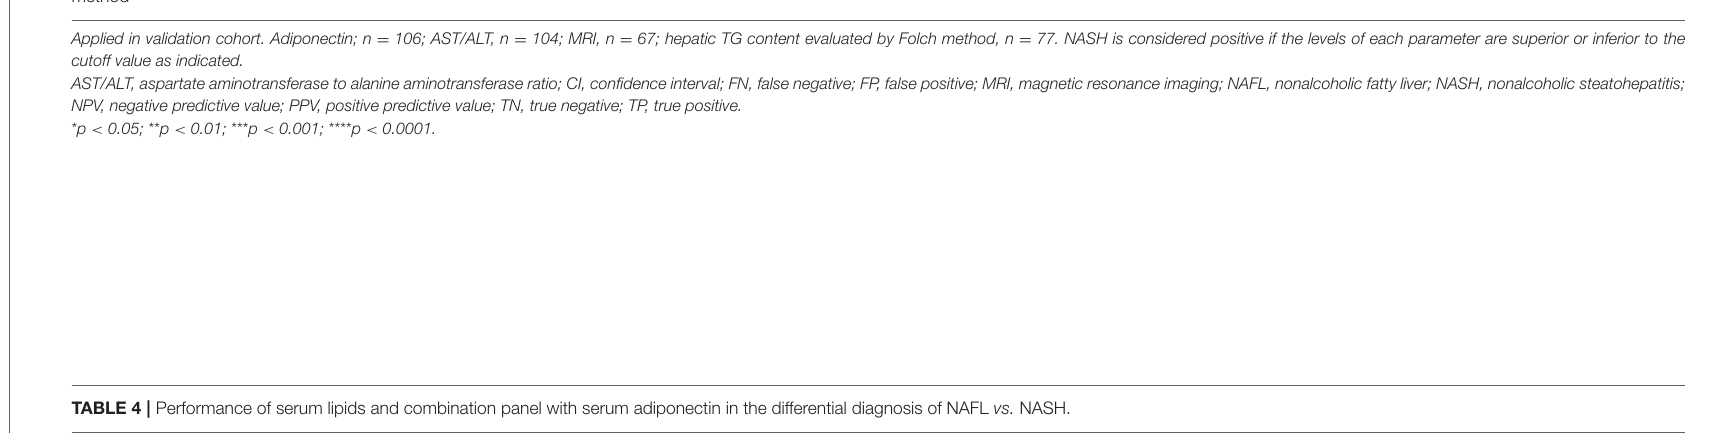
TABLE 4 | Performance of serum lipids and combination panel with serum adiponectin in the differential diagnosis of NAFL vs. NASH. Cutoff AUROC (95% CI) Sensitivity (95% CI)